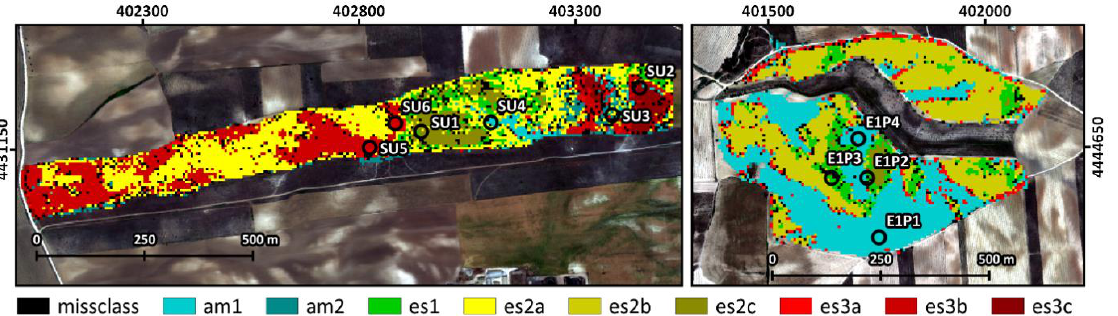
Figure 13. Classification of SEAS based on best RF prediction for field plot SU ( left ) and E1 ( right ). Black pixel represents misclassification of the RF model.